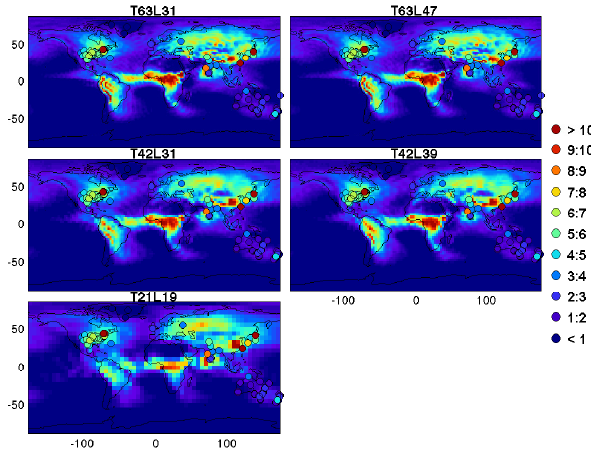
Fig. 5. 1998–2002 mean deposition flux of 210 Pb atoms (1000 m − 2 s − 1 ) with different model resolutions. The dots show the location and observed deposition flux of the measurement stations (refer- ences given in the text).